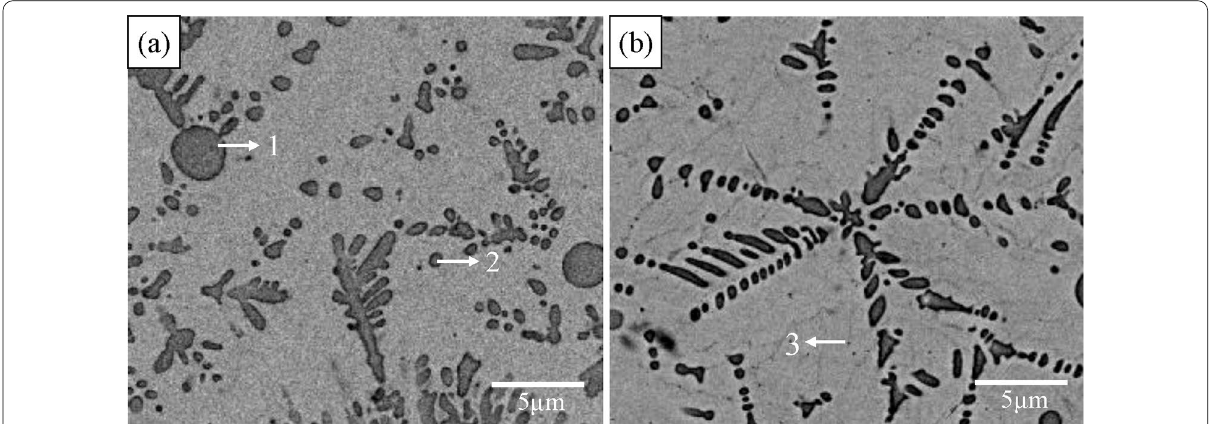
Figure 9 Typical dendritic structures in zone 2 of S2